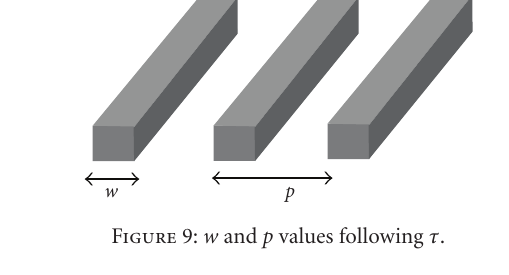
Figure 9: w and p values following τ .